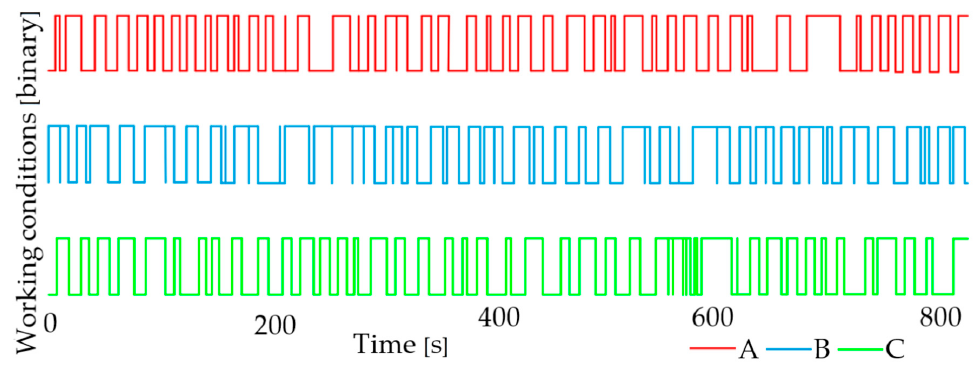
Figure 8. Characteristic of the signal from the optical sensor in the feed channel: A: Carburettor fuel supply system; B: Injector fuel supply system; C: Injector fuel supply system equipped with an adaptive drive control system.